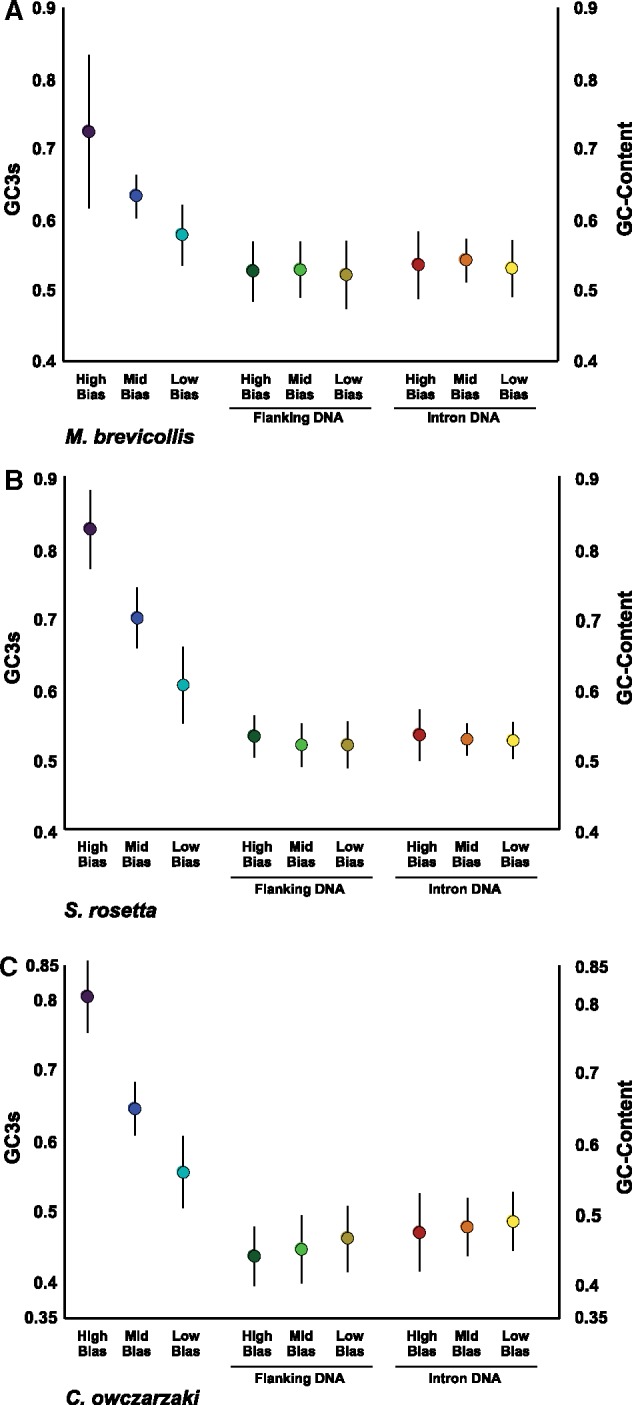
Comparisons of mean GC3s and noncoding DNA GC-content for the holozoan protists. The bars represent the standard deviation of the values from each category. The GC3s values are on the left y-axis (purple dot, highly biased; dark blue, mid bias; light blue, low bias). Noncoding GC content is shown on the right y-axis axis (Flanking DNA. Dark green dot, highly biased; light green, mid bias; mustard, low bias. Intron DNA. Red dot, highly biased; orange, mid bias; yellow, low bias).